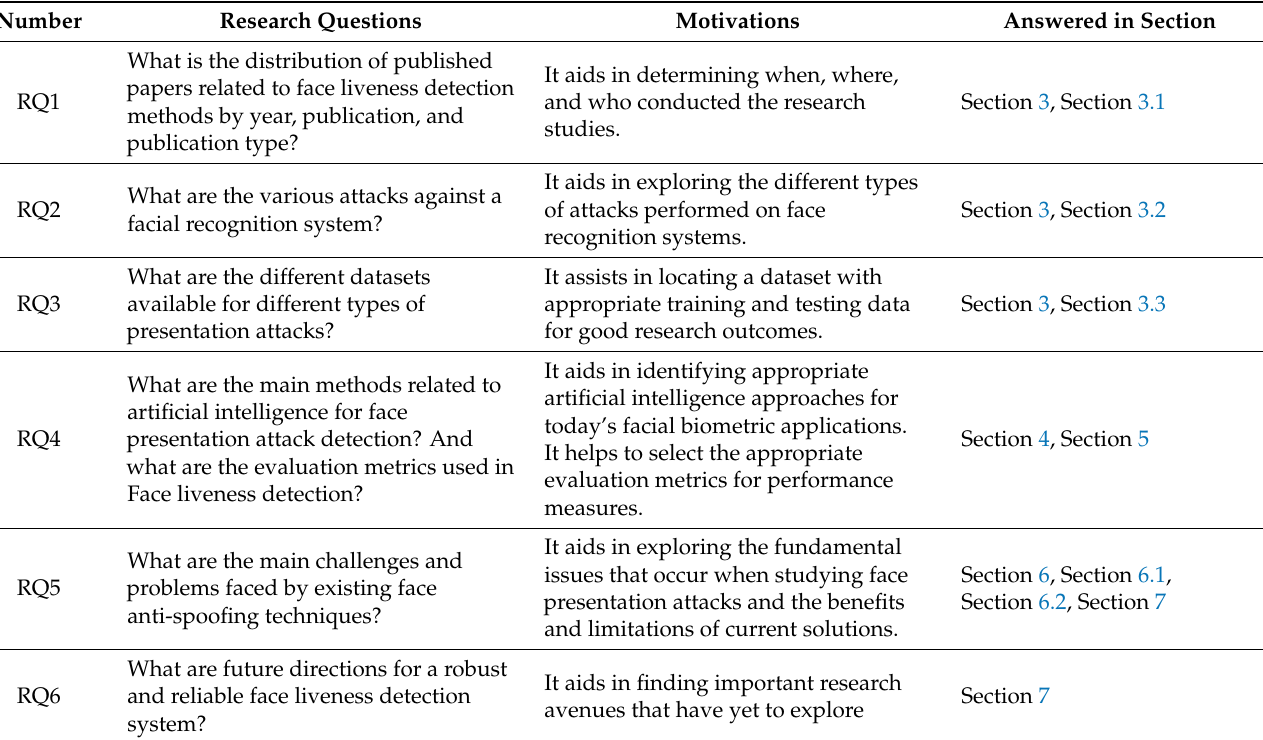
Table 3. Research